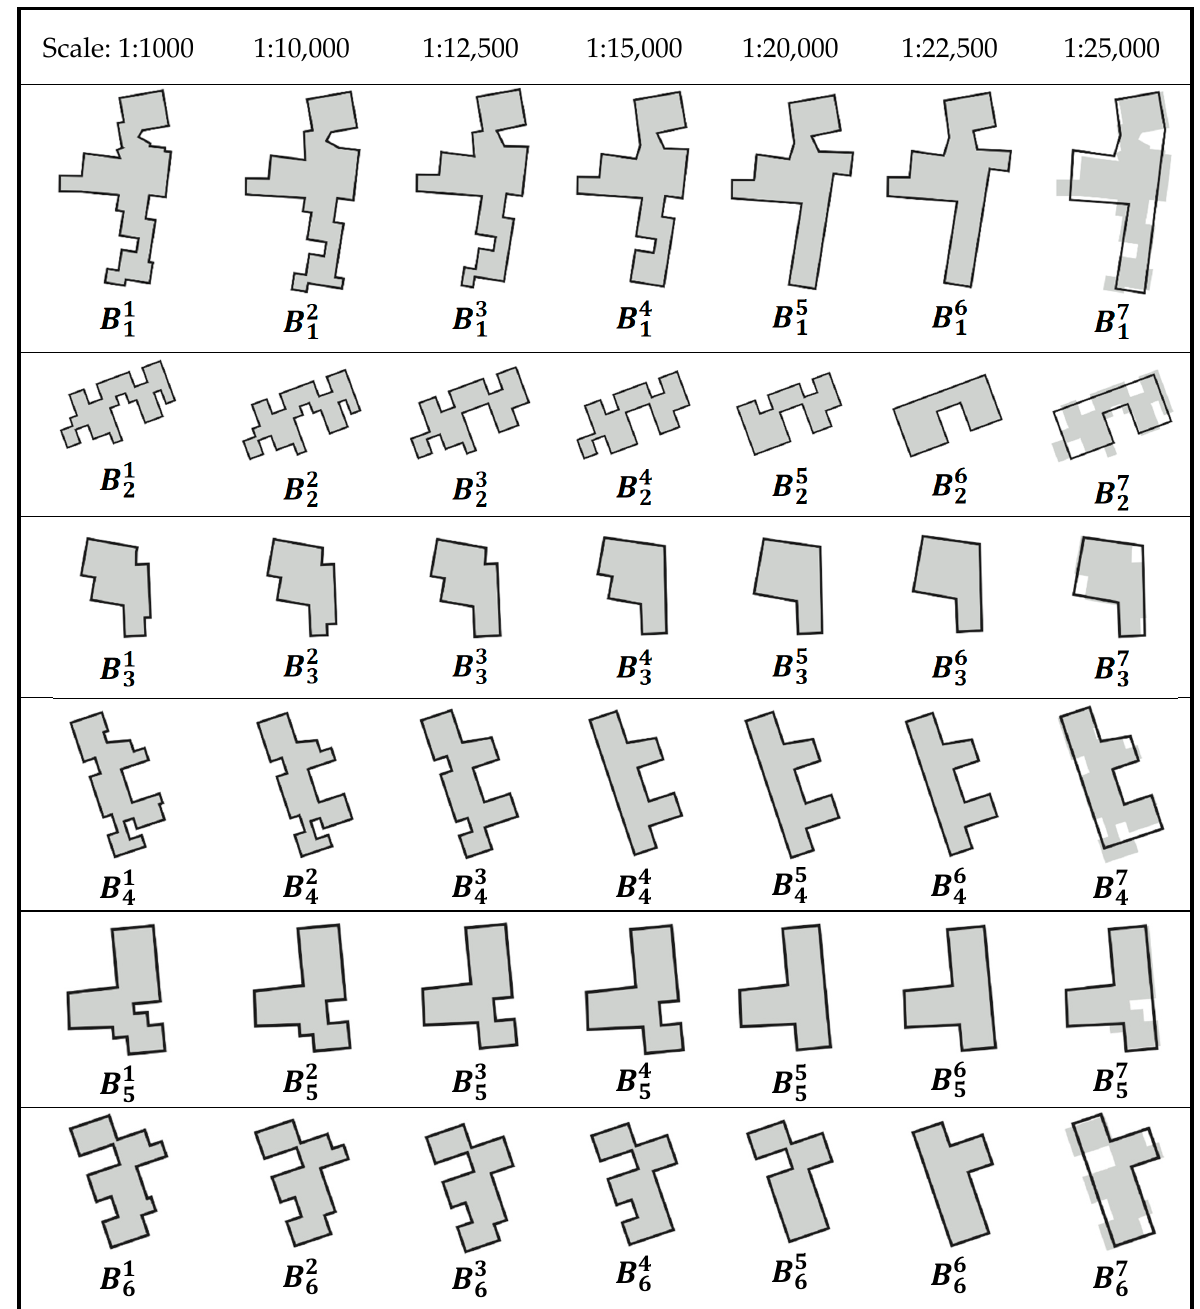
Figure 14. Multi-scale simplification of buildings.